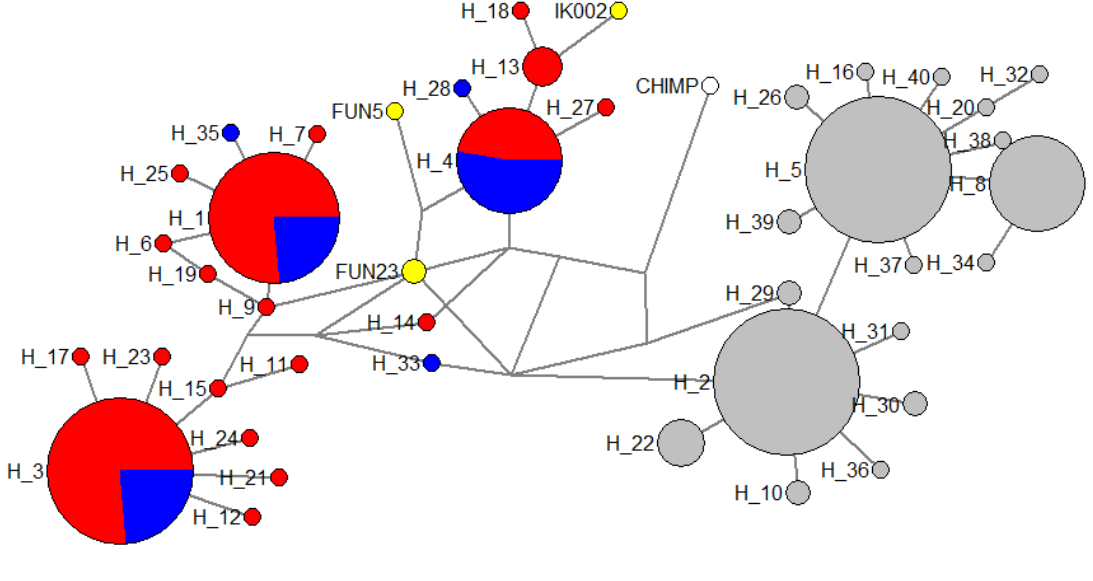
Figure 6. Network of haplotypes from three Jomon samples, extant JPT, extant CHB and the chimpanzee. Haplotypes which have C alleles are represented by gray circles and the other haplotypes are colored (Jomon samples (IK002, FUN5, and FUN23): yellow; extant JPT: red; extant CHB: blue; chimpanzee (CHIMP): white). The size of the circle represents the number of haplotypes. The branch length is not proportional to the number of substitutions. The labels starting with “H” represent the haplotype number defined in our network analysis. The corresponding haplotype numbers defined in extant samples are presented in Table S5.